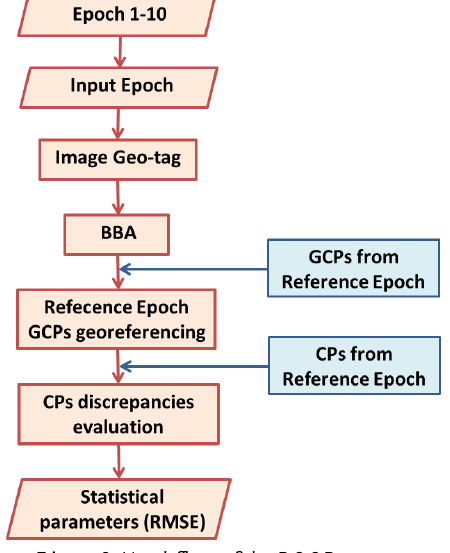
Figure 3. Workflow of the RGCP process